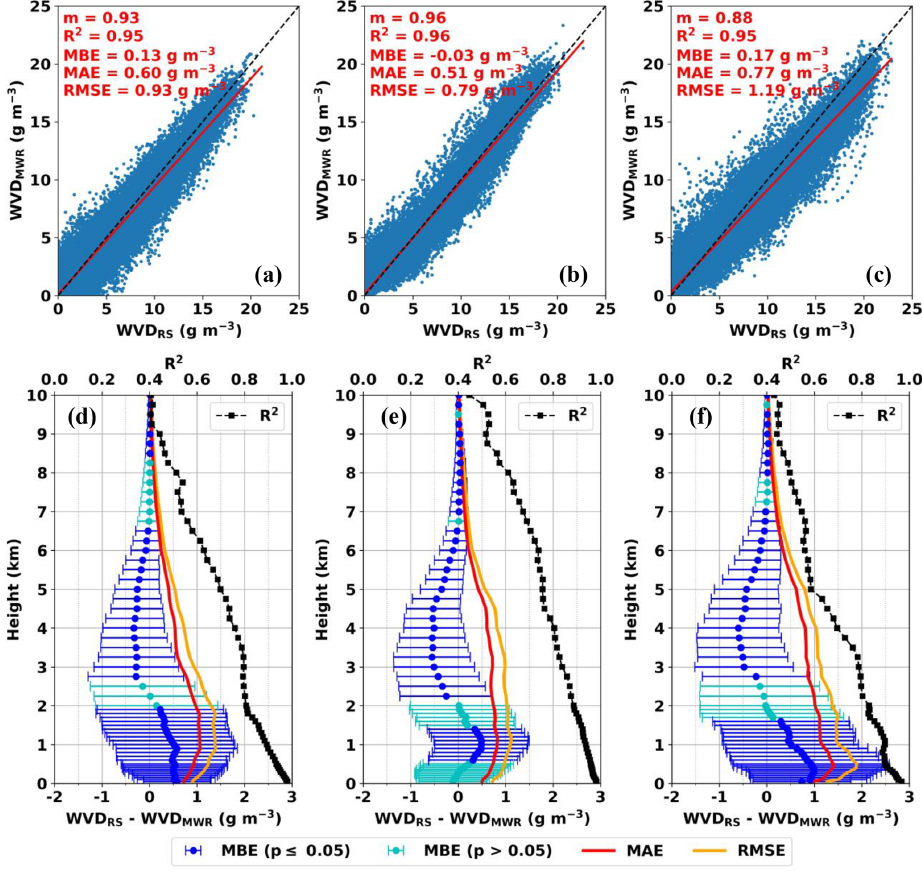
Figure 8. Scatterplots for RS- and MWR-measured water vapor density (WVD) at three NYSM Profiler Network sites at (a) Buffalo, (b) Albany, and (c) Stony Brook. Vertical profiles of R 2 , MBE with 1 standard deviation error bars, MAE, and RMSE for the same variable at (d) Buffalo, (e) Albany, and (f) Stony Brook.